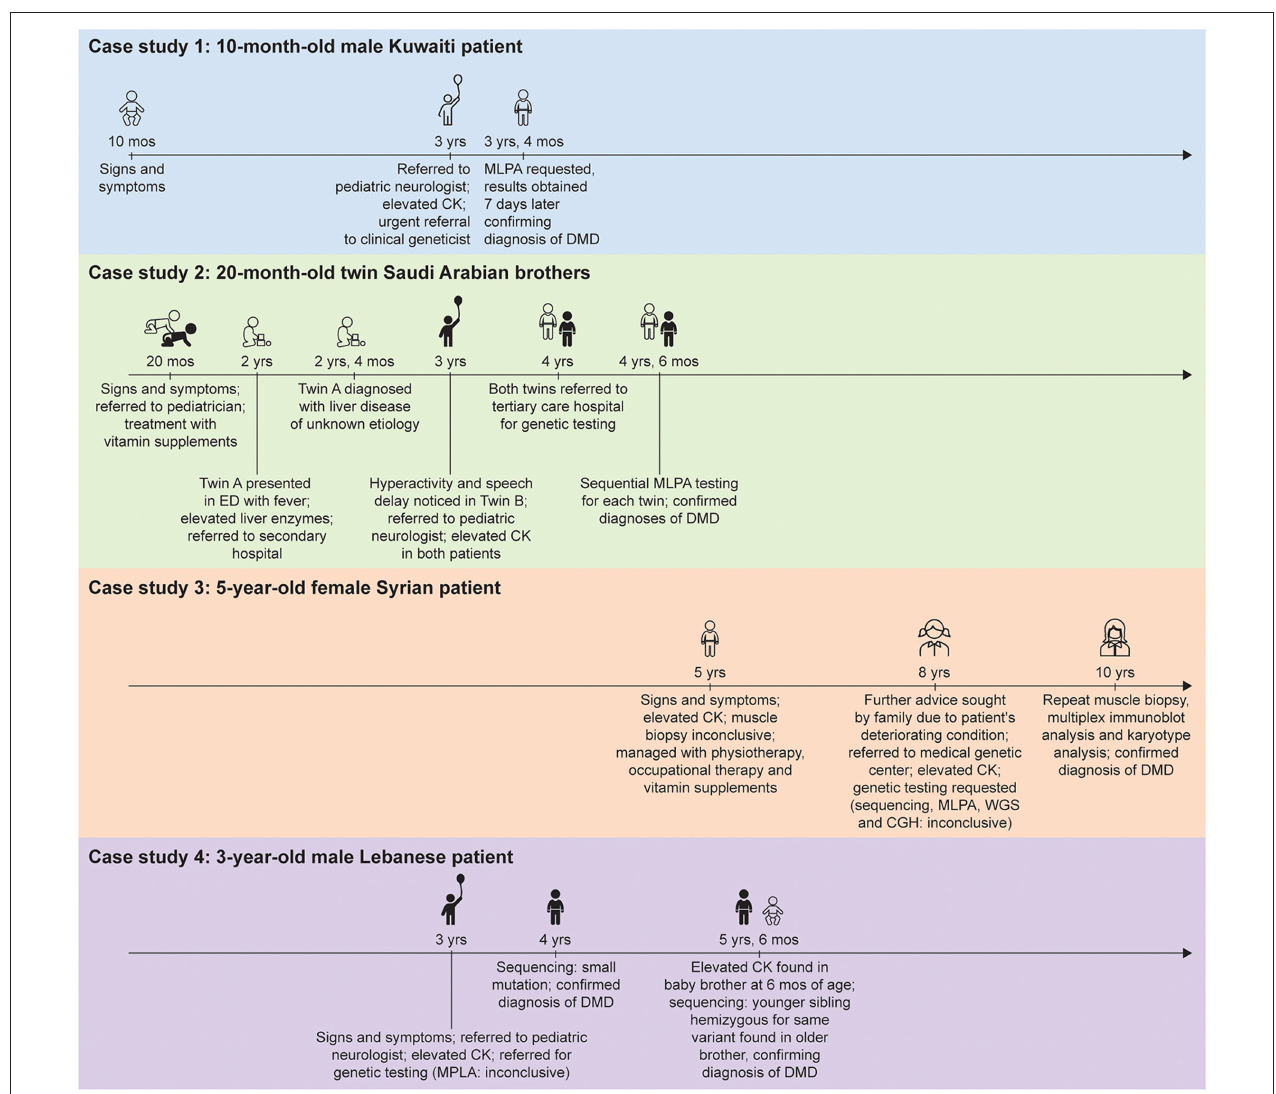
FIGURE 1 | Timeline from presentation of first signs and symptoms of disease to genetic diagnosis for the patients described in the case studies. CGH, comparative genomic hybridization; CK, creatine kinase; DMD, Duchenne muscular dystrophy; ED, emergency department; MLPA, multiplex ligation-dependent probe amplification; WGS, whole genome